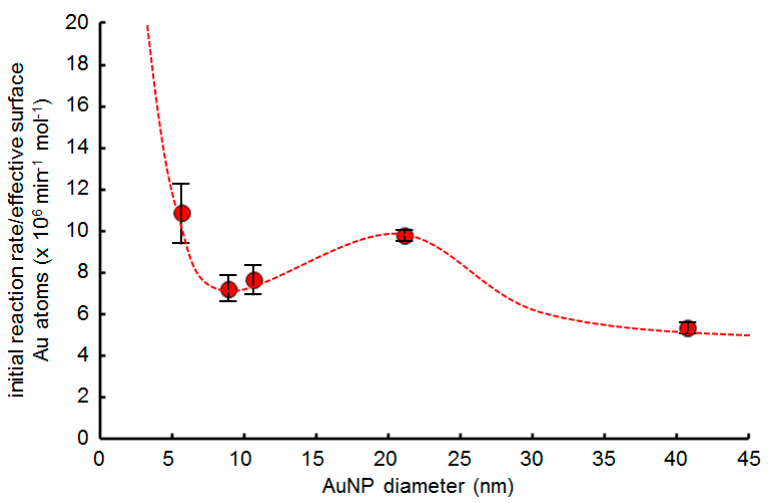
Figure 8. Size dependence of the catalytic activity of dodecanethiolate SAM-functionalized AuNP-